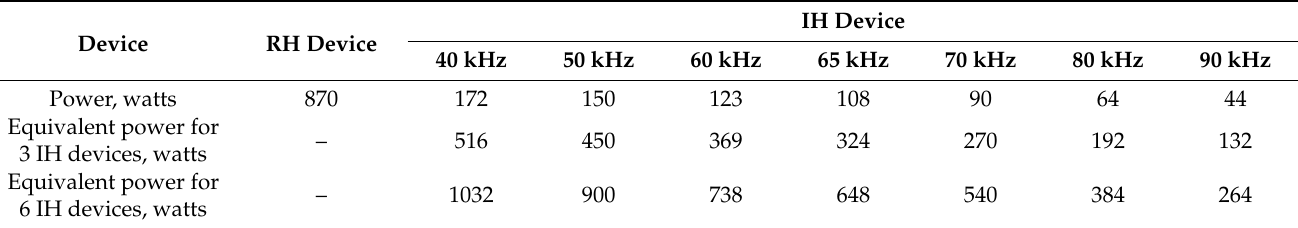
Table 2. Power consumption of RH and IH